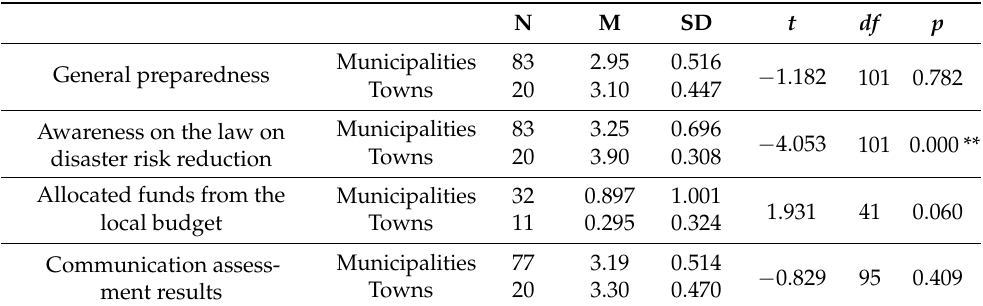
Figure 5. Preparedness (Likert scale) of the local self-government in Serbia for disaster events. Table 4. Independent samples t -test results comparing towns and municipalities of Serbia regarding various